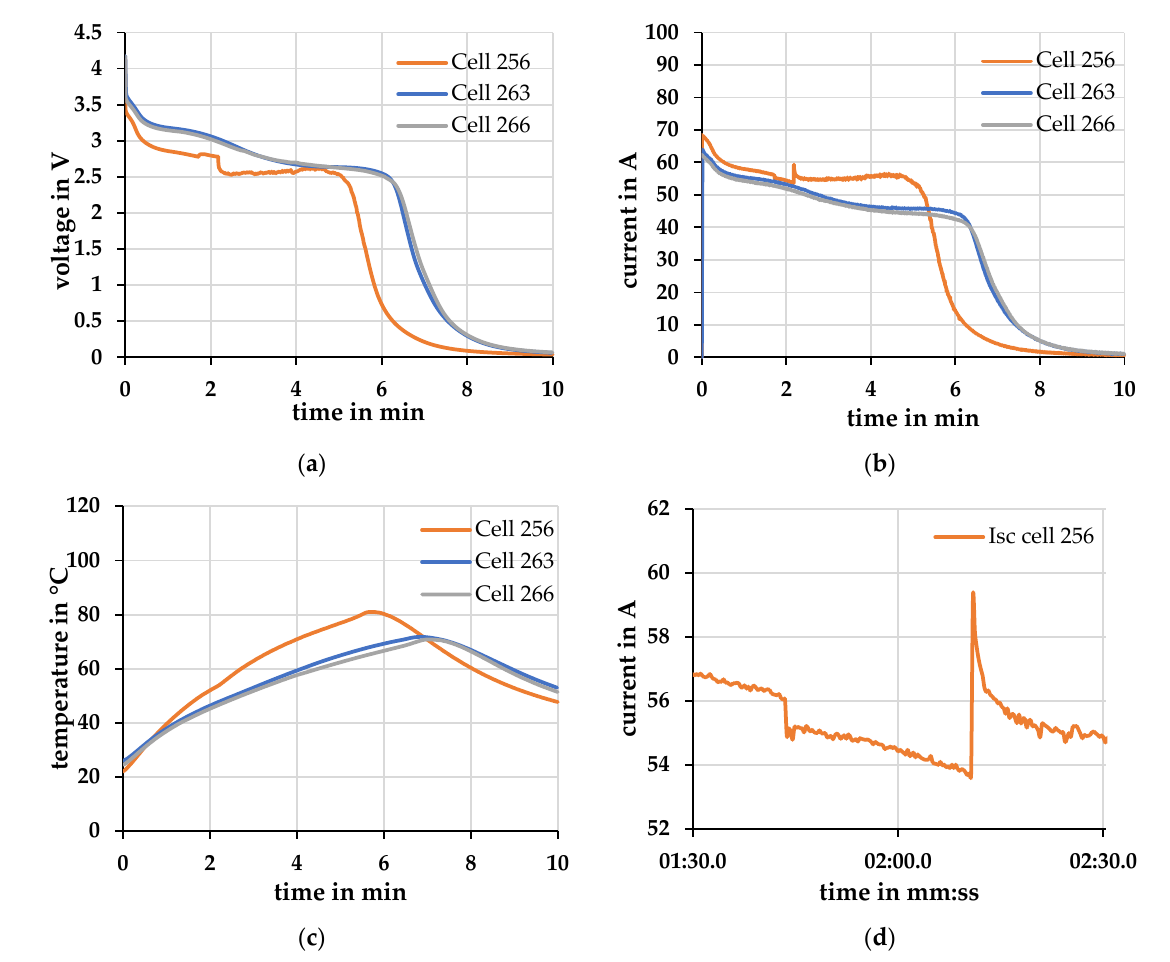
Figure 8. Short-circuit at T ambient = 20 °C ± 2 °C. ( a ) Voltage; ( b ) Current; ( c ) Temperature; ( d ) Current peaks in current profile cell 256.